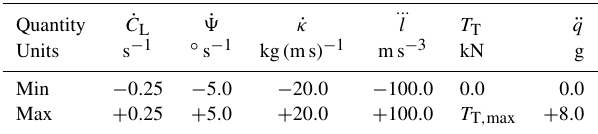
Table 2. Bound constraints applied to control variables u and other variables used in the optimal control problem (Eq. 33). The maxi- mal tether tension depends on the wing design and is discussed in Sect.